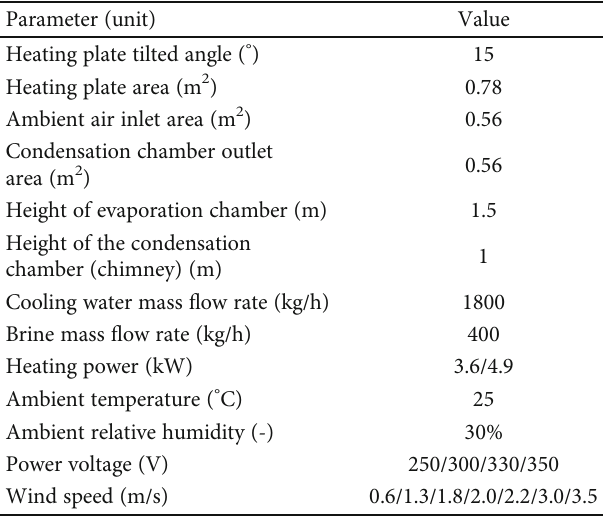
Figure 3: Schematic of the experimental setup: (a) the components and their connections; (b) photo of the experimental setup. Table 1: Parameters of the experimental